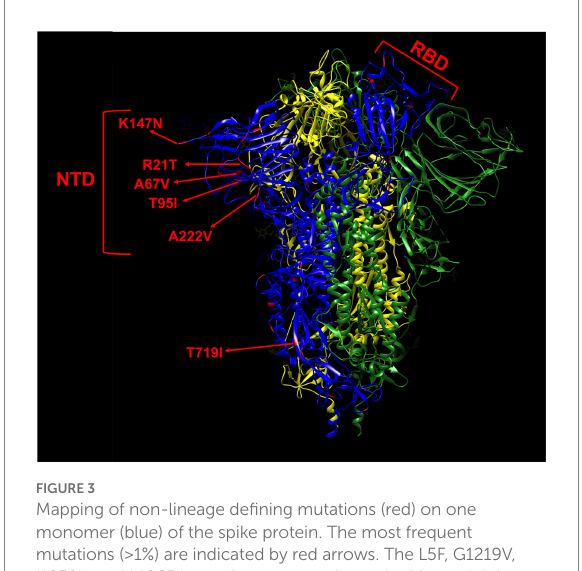
FIGURE 3 Mapping of non-lineage defining mutations (red) on one monomer (blue) of the spike protein. The most frequent mutations (>1%) are indicated by red arrows. The L5F, G1219V, I1232L, and L1265I mutations are not shown in this model due to their proximity to the termini as the model only comprises residues 14–1,147. The spike is shown in its closed state as a trimer of 3 monomers colored in blue, yellow, and green, respectively. NTD, N-terminal domain. RBD, receptor binding